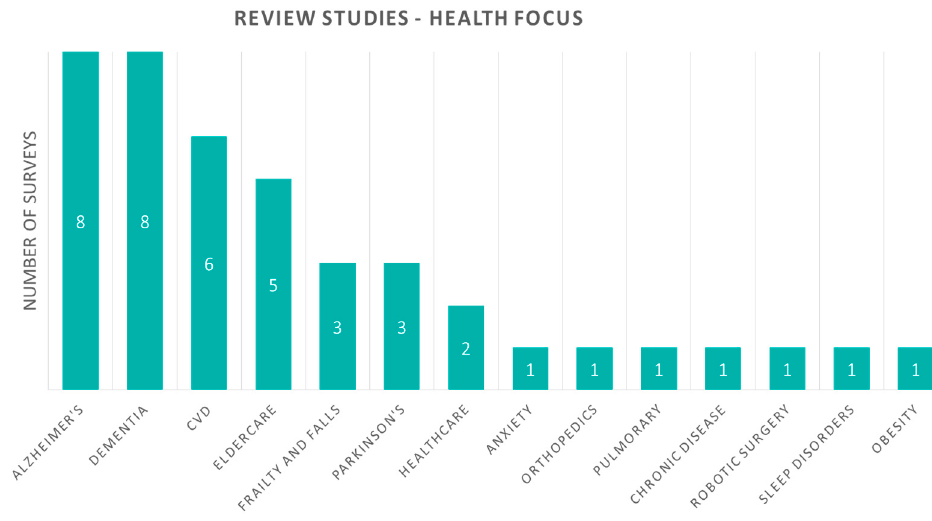
Figure 3. Review studies according to their health focus. CVD, cardiovascular disease.